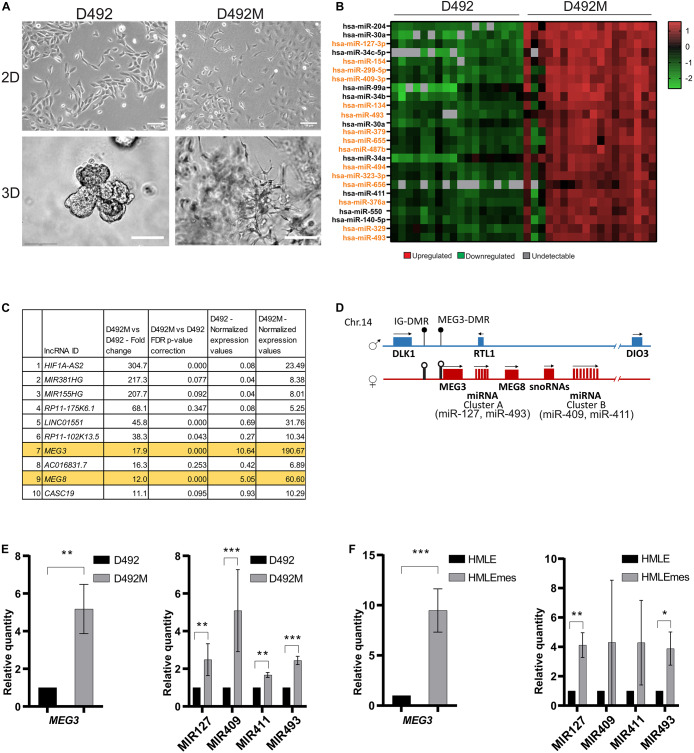
The DLK1-DIO3 locus is upregulated in breast epithelial stem cells undergoing EMT. (A) D492 and D492M generate branching and mesenchymal structures in 3D culture, respectively. In 2D culture, D492 is cuboidal in shape and D492M is more spindle shaped. Scale bar = 100 μm. (B) Majority of the top upregulated miRNAs in D492M are from the DLK1-DIO3 locus. Microarray heat map showing top 25 upregulated miRNAs in D492M compared to D492. 15 of them are from the DLK1-DIO3 locus (highlighted in orange). (C) LncRNAs from the DLK1-DIO3 locus are among the most upregulated in D492M. RNAseq data showing top ten differentially expressed lncRNA, with lncRNAs from DLK1-DIO3 locus (MEG3 and MEG8) highlighted in orange. (D) Schematic figure of the DLK1-DIO3 locus. The DLK1-DIO3 locus is located on chromosome 14 and is imprinted. It contains three paternally expressed protein coding genes (DLK1, RTL1, and DIO3) and many maternally expressed non-coding genes, among them lncRNAs (MEG3 and MEG8) and over 50 miRNAs, among them MIR127 and MIR493 located in cluster A and MIR409 and MIR411 located in cluster B and numerous C/D-box-containing small nucleolar RNAs (snoRNAs). DMR – differentially methylated region, filled circles represent methylated DMRs, and unfilled represent unmethylated DMRs. (E) Upregulation of selected ncRNA from the DLK1-DIO3 locus verified with qRT-PCR. Graphs showing higher expression of MEG3 in D492M compared to D492 (left) and higher expression of four representative miRNAs (MIR127, MIR493, MIR409, and MIR411) at the DLK1-DIO3 locus in D492M compared to D492 (right). Results shown as mean ± SD. Unpaired t-test was used to test significance: **p ≤ 0.01; ***p ≤ 0.001; n = 3. (F) ncRNAs from the DLK1-DIO3 locus are upregulated in HMLEmes. qRT-PCR showing higher expression of MEG3 and representative miRNAs (MIR127, MIR493, MIR409, and MIR411) from DLK1-DIO3 locus in HMLEmes compared to HMLE. Results shown as mean ± SD. Unpaired t-test was used to test significance: *p ≤ 0.05; **p ≤ 0.01; ***p ≤ 0.001; n = 3.